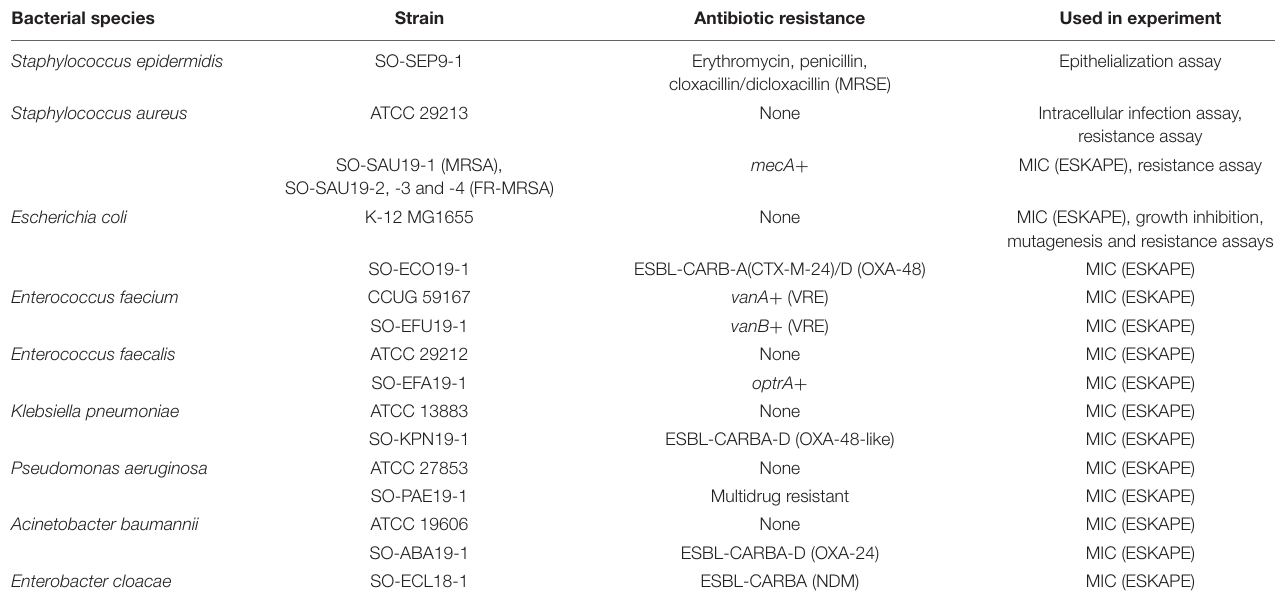
TABLE 1 | Bacterial strains used in this